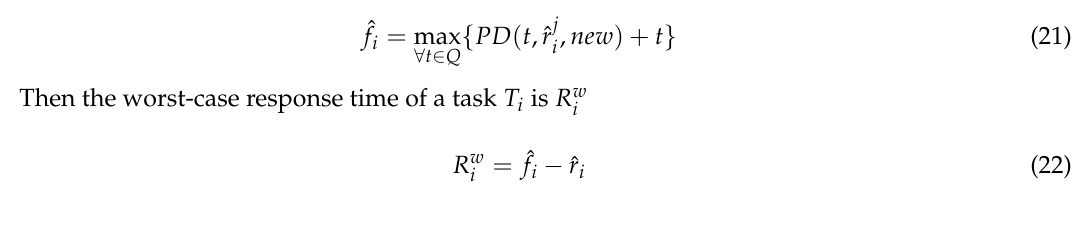
Algorithm 1 Worst-Case Response time R w